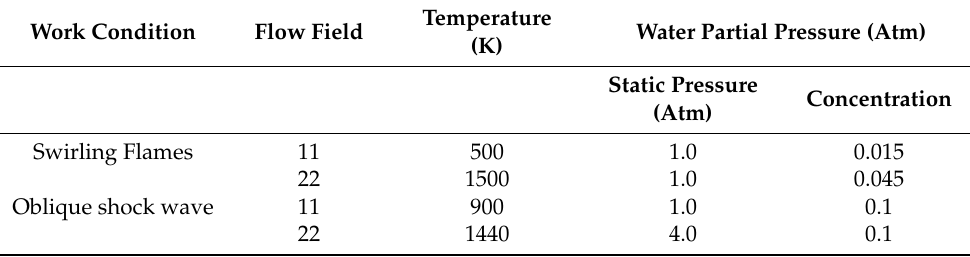
Table 1. Physical parameters of the flow field under two working conditions.